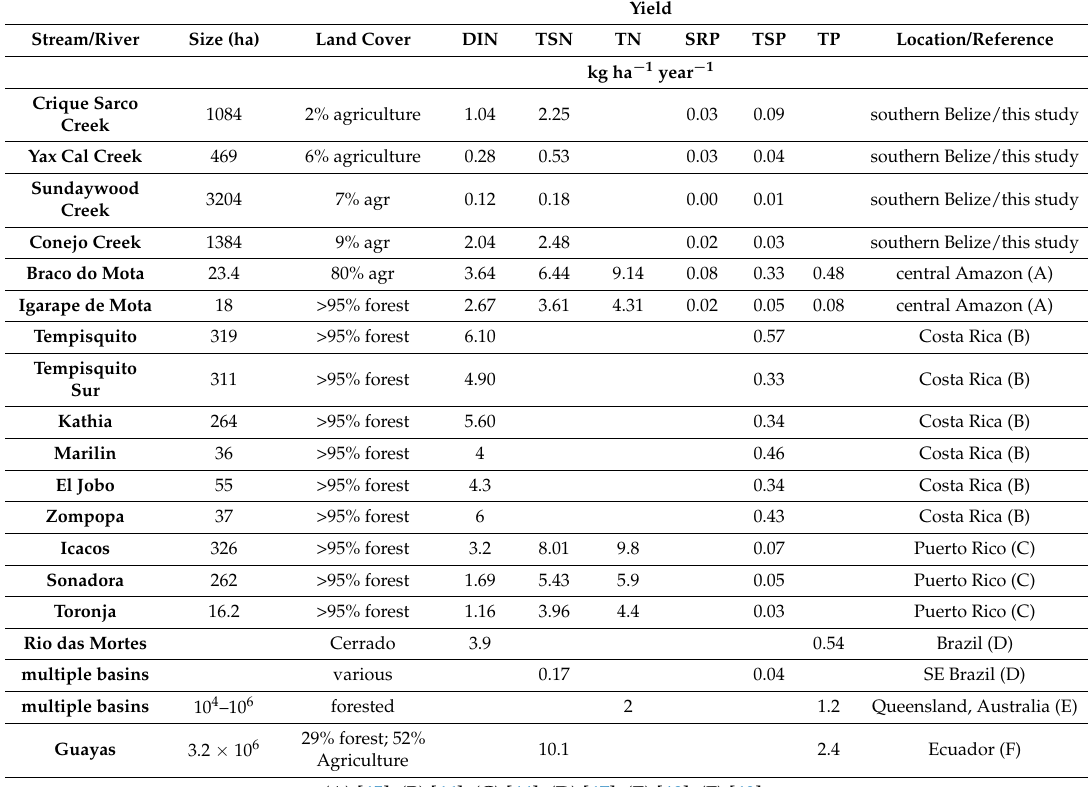
Table 6. Comparison of annual nutrient export values (kg ha − 1 year − 1 ) from the study catchments with values from other tropical